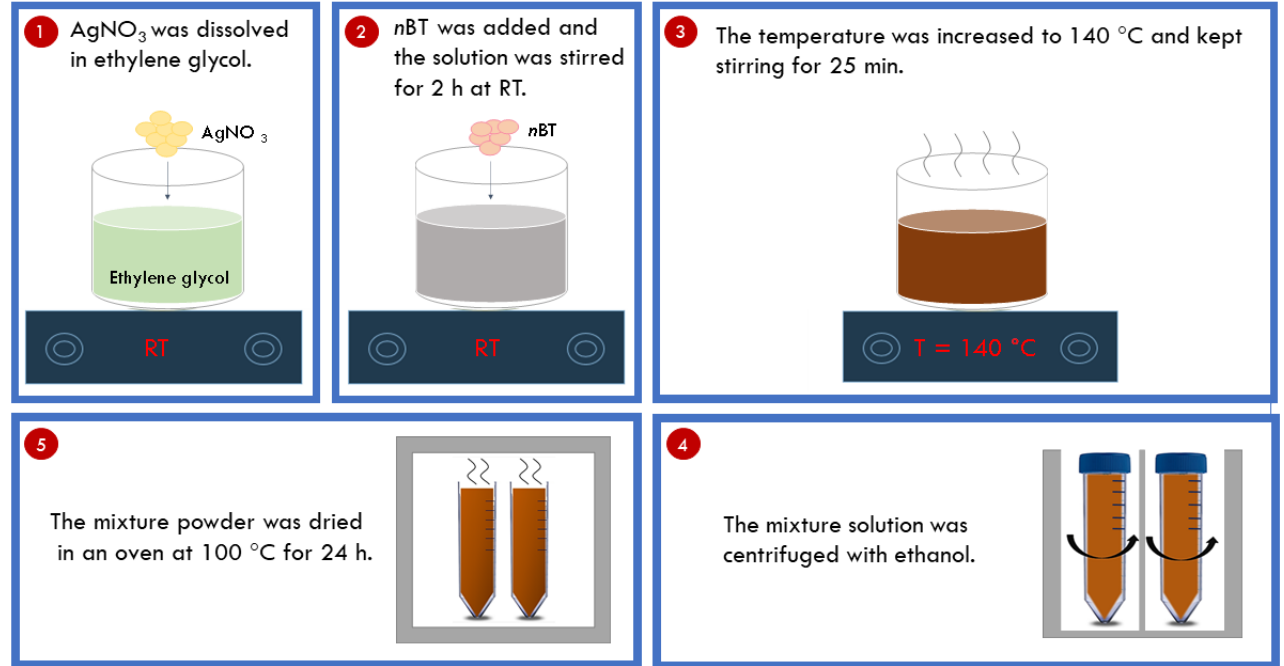
Figure 1. Schematic figure of the synthesis of Ag- n BT hybrid particles.